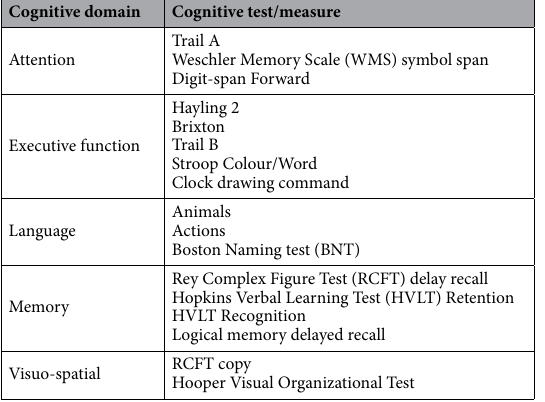
Table 6. The neuropsychiatric